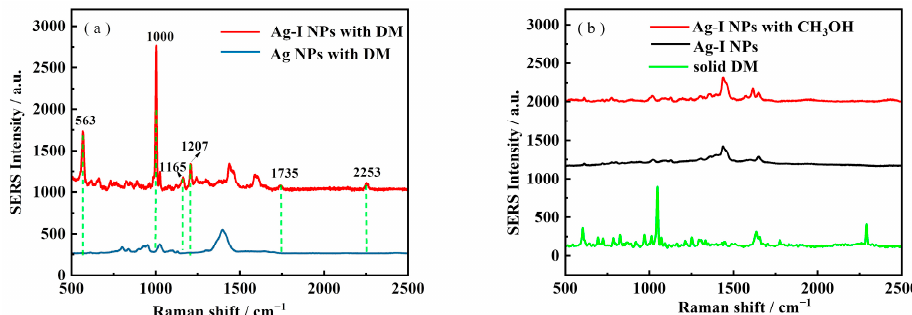
Figure 2. ( a )The SERS of DM using Ag-I NPs and Ag NPs; ( b ) Ag-I NPs for CH 3 OH; Ag-I NPs; and the Raman Spectra of solid DM. Laser power: 54 mW. Integration time: 1 s. Objective: 50 ×